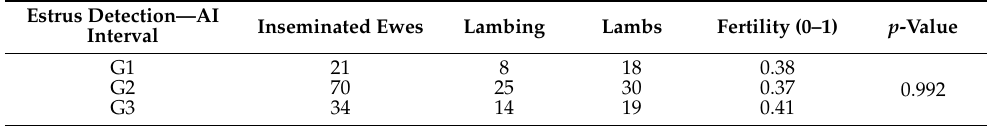
Table 6. Estrus detection—AI interval (h) and fertility in Churra ewes in Spain. Estrus Detection—AI Interval